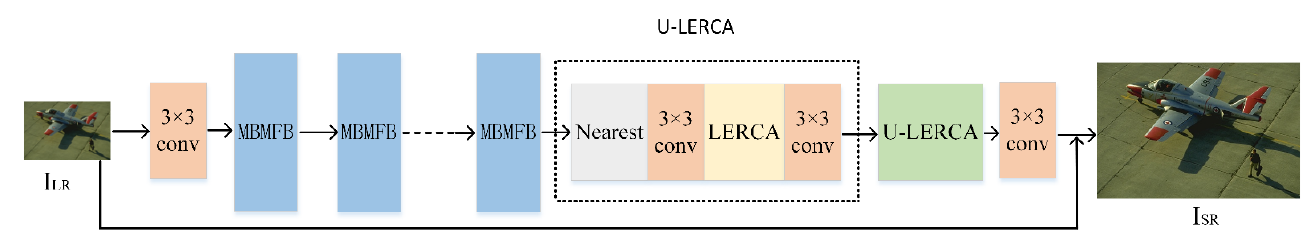
Figure 1. Overall block diagram of multibranch feature multiplexing fusion network with mixed multilayer attention .